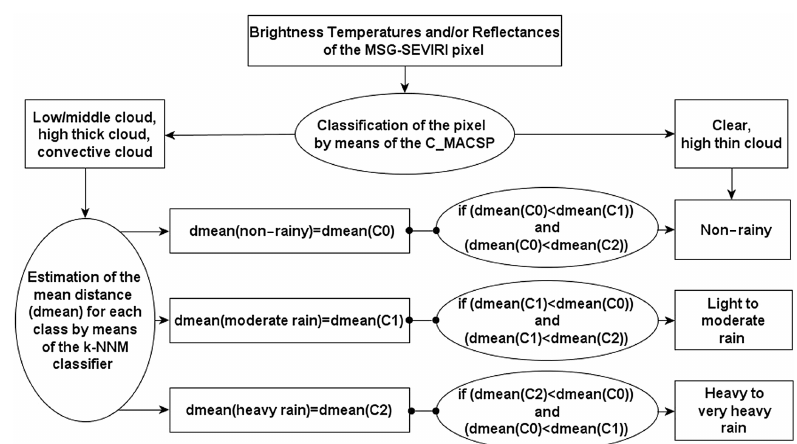
Figure 1. Flowchart of the RainCEIV